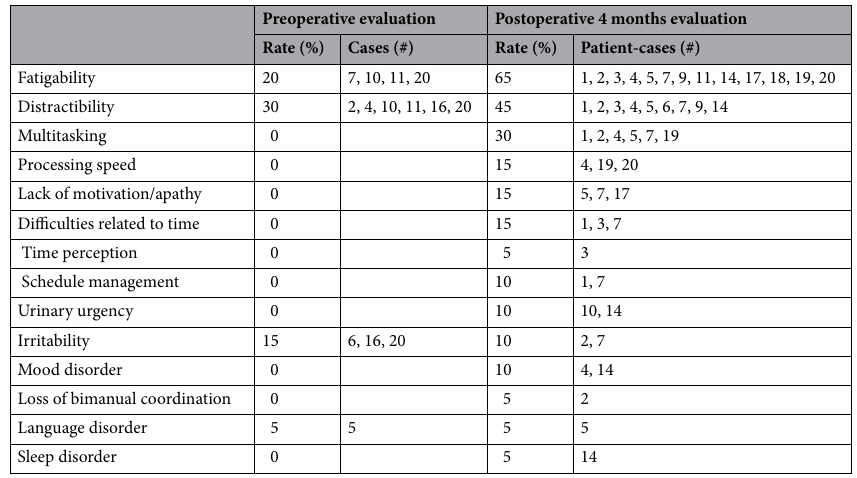
Table 4. Subjective complaints spontaneously reported by patients preoperatively and 4 months after surgery.